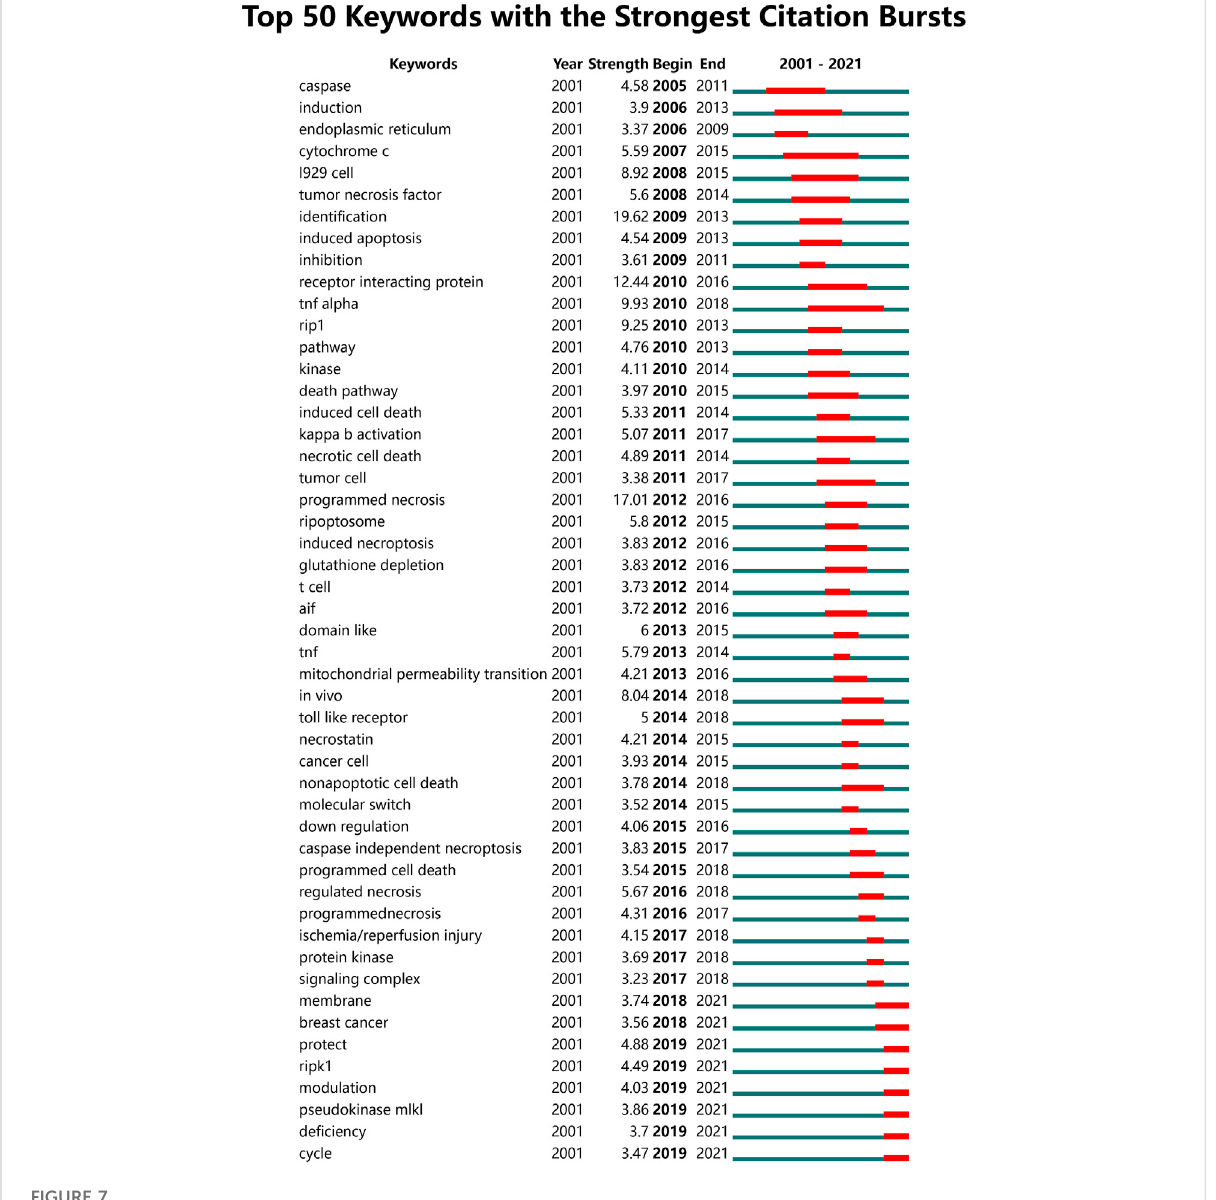
Frontiers in Cell and Developmental